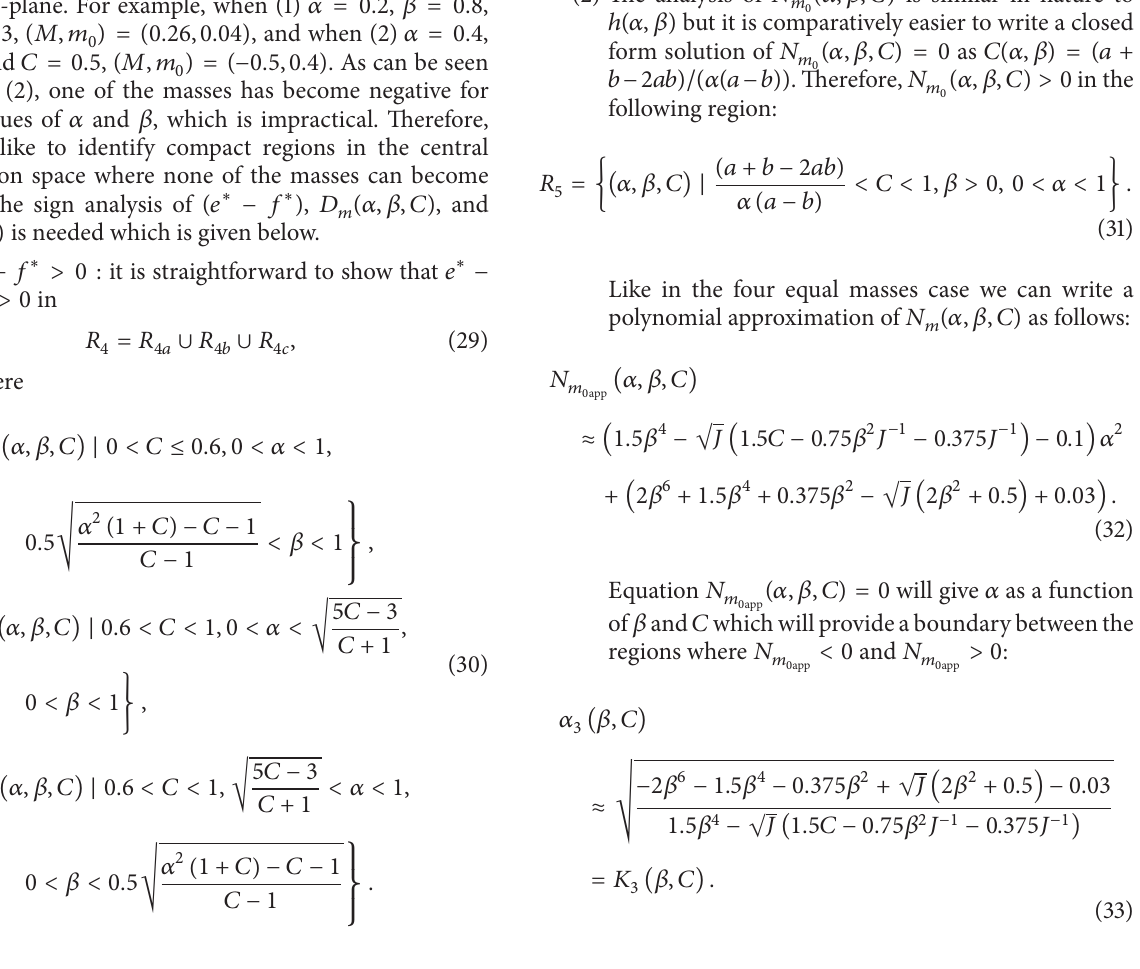
Region 𝑅 4 is given in Figure